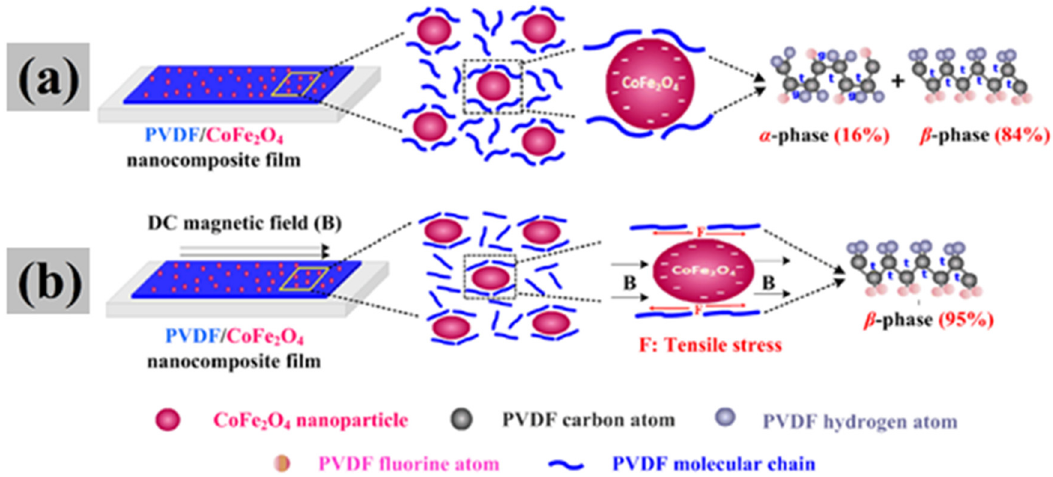
Figure 17: Schematic illustration of the formation of the β - phase in the PVDF/CoFe 2 O 4 composites prepared ( a ) without and ( b ) with a DC magnetic fi eld [ 54 ]